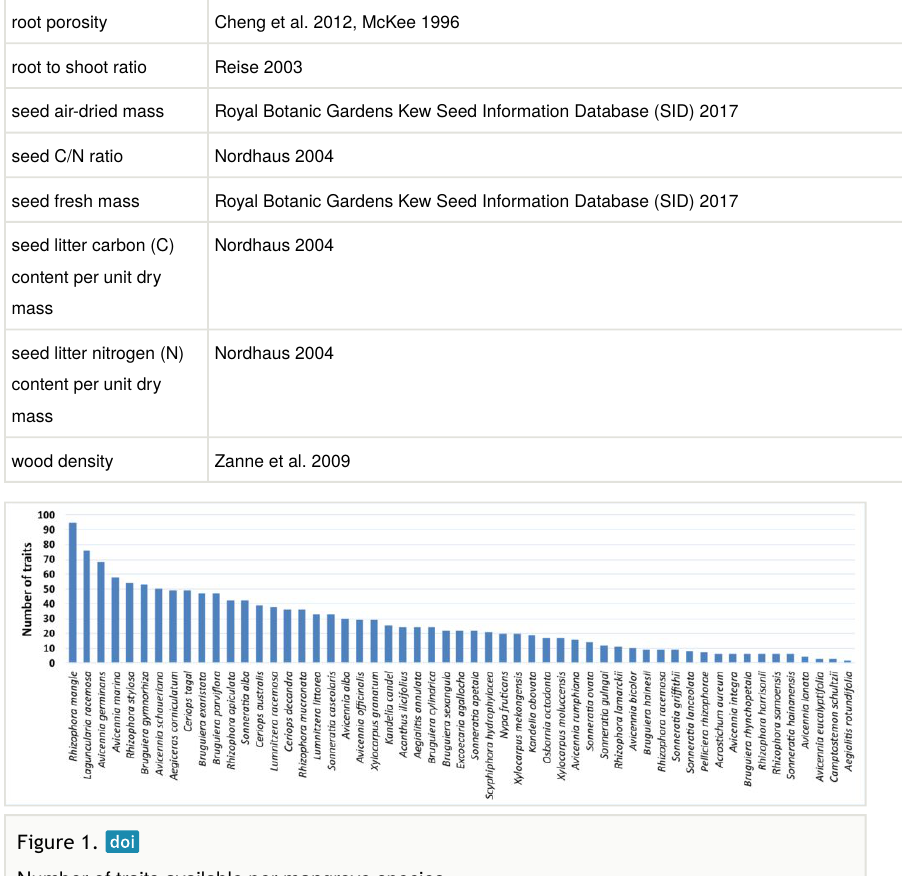
Number of traits available per mangrove